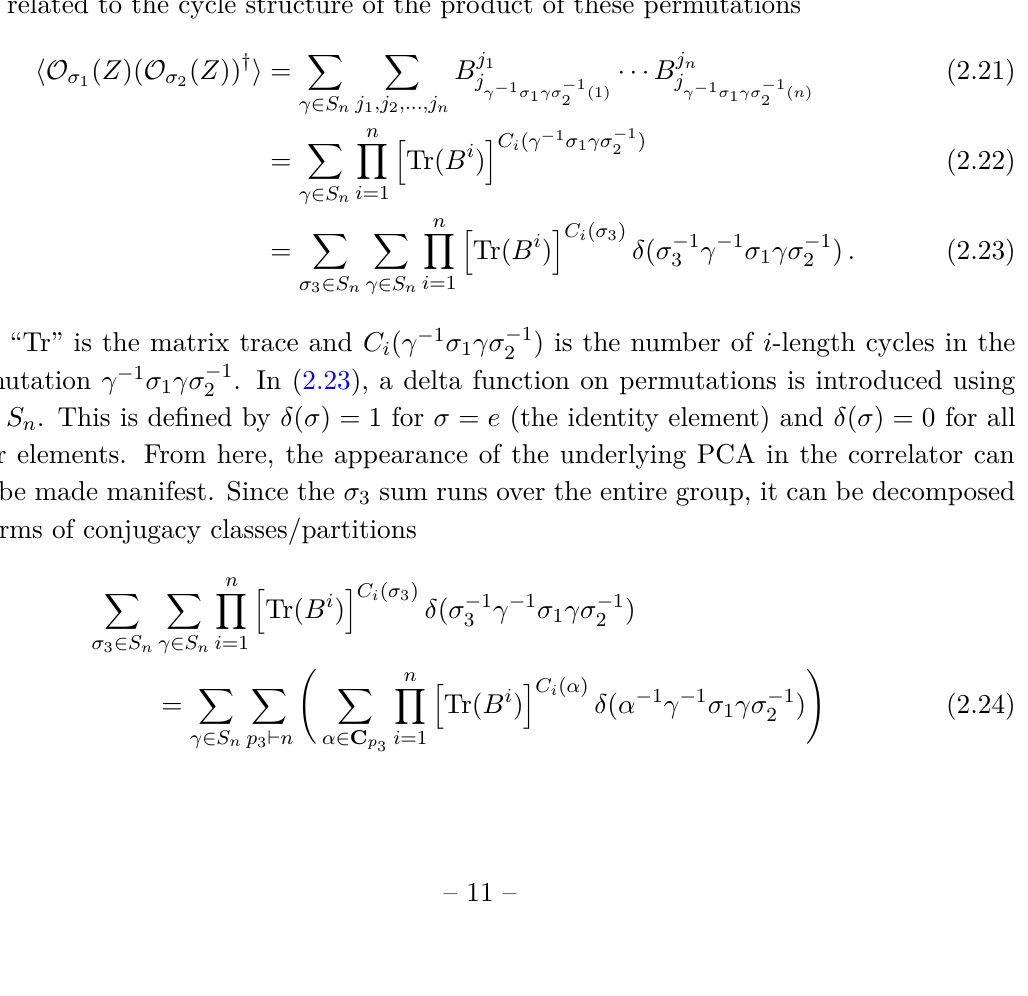
( L τ ) k 1 ,...,k n = ( L στ ) i 1 ,...,i n , where j 1 ,...,j n j 1 ,...,j n k 1 ,...,k n